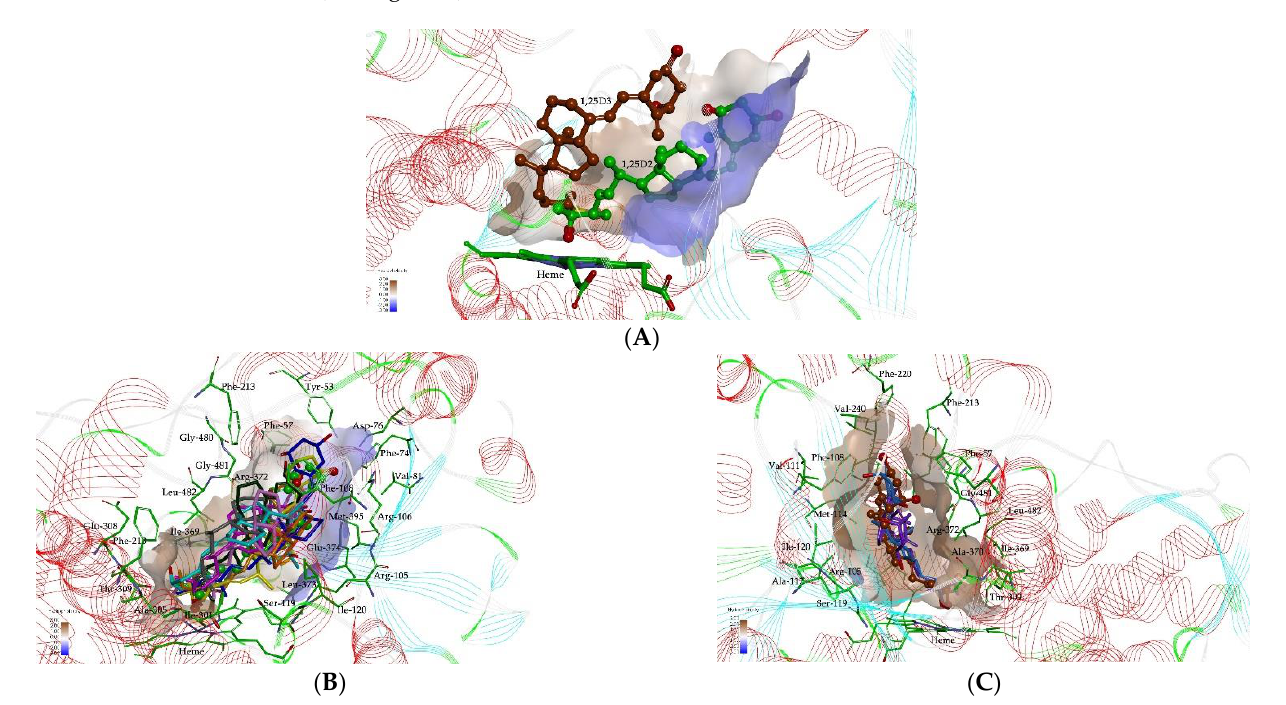
Figure 2. Close-up view of an active site of the CYP3A4 structure. ( A ) View of the binding of 1,25D2 (green) and 1,25D3 (brown) in the active site CYP3A4. ( B , C ) View of 1,25D2 and 1,25D3 analogs in the pocket of CYP3A4. Predicted superposition of compounds. ( B ) 1,25D2 (C atoms shown as green), PRI-5106 (C atoms shown as dark green), PRI-5105 (C atoms shown as magenta), PRI-1916 (C atoms shown as cyan), PRI-1917 (C atoms shown as pink), PRI-1906 (C atoms shown as blue), PRI-1907 (C atoms shown as grey), PRI-5201 (C atoms shown as yellow), and PRI-5202 (C atoms shown as orange). ( C ) PRI-1901 (C atoms shown as purple) and PRI-2205 (C atoms shown as blue). Surface hydrophobicity is depicted by the shaded colors: negative values (blue) correspond to hydrophilic residues, whereas positive values (brown) correspond to hydrophobic residues.